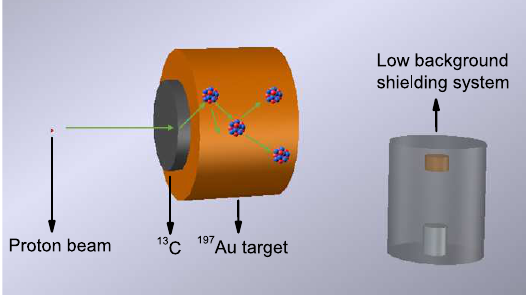
Figure 1. Scheme of detector setup